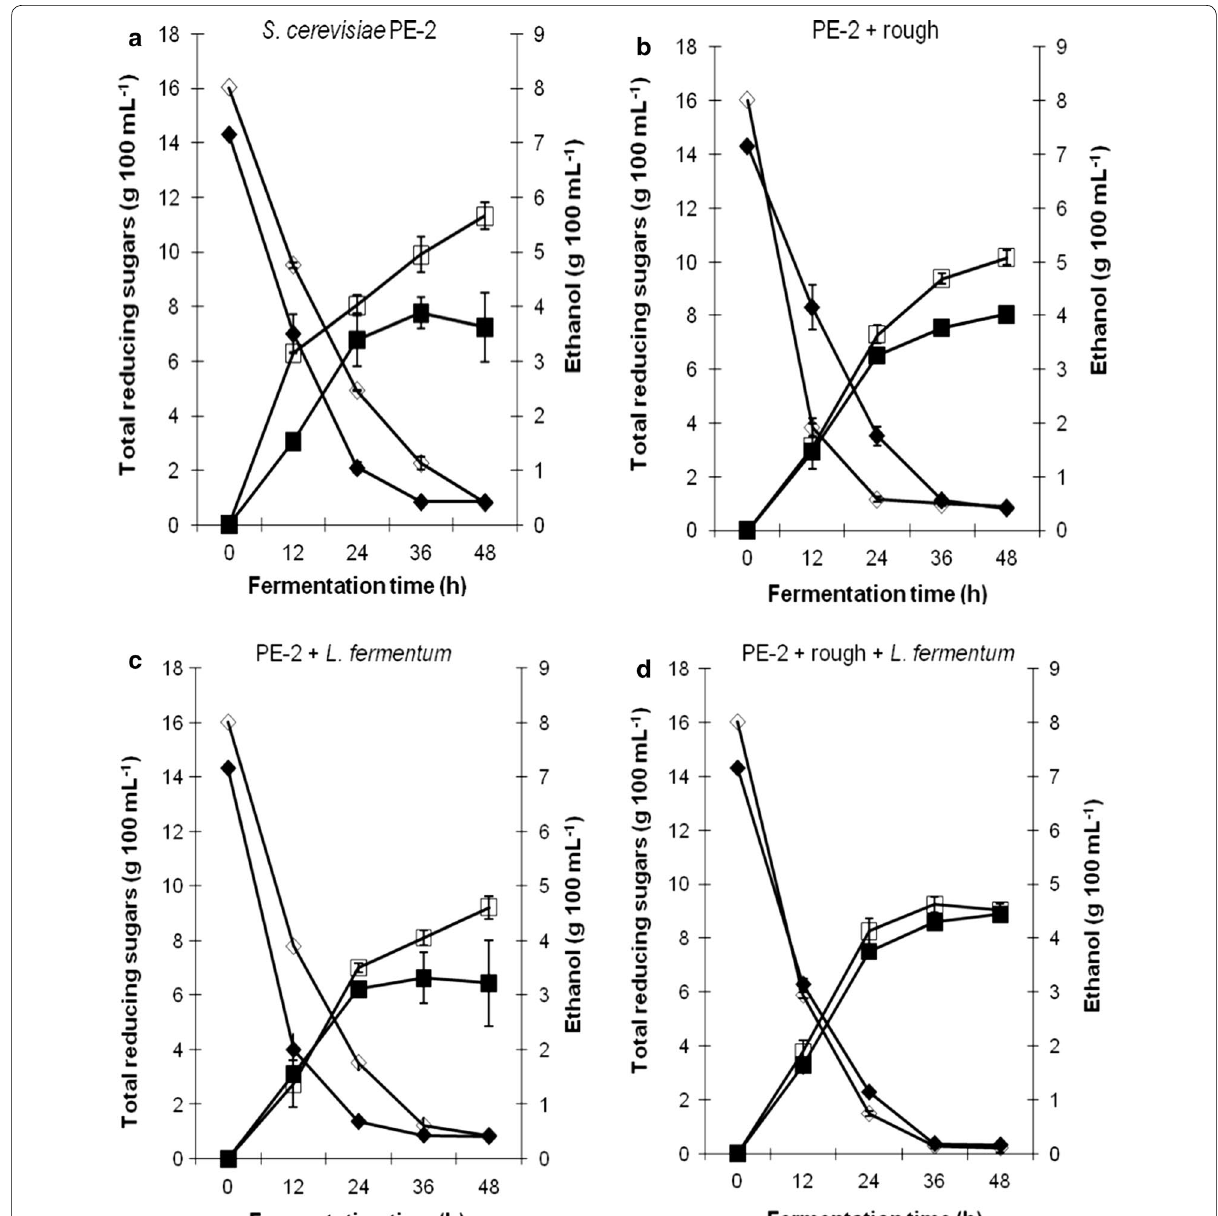
Fig. 1 Total reducing sugars (g 100 mL − 1 , diamonds) and ethanol production (g 100 mL − 1 , squares) in fermentations carried out with the industrial S. cerevisiae yeast (PE‑2) contaminated with the rough strain of S. cerevisiae (rough) and/or L. fermentum (Lf), in sugarcane juice (empty symbols) or molasses (solid symbols) at 30 °C for 48 h. Results are the mean of two replicates and error bars correspond to the standard